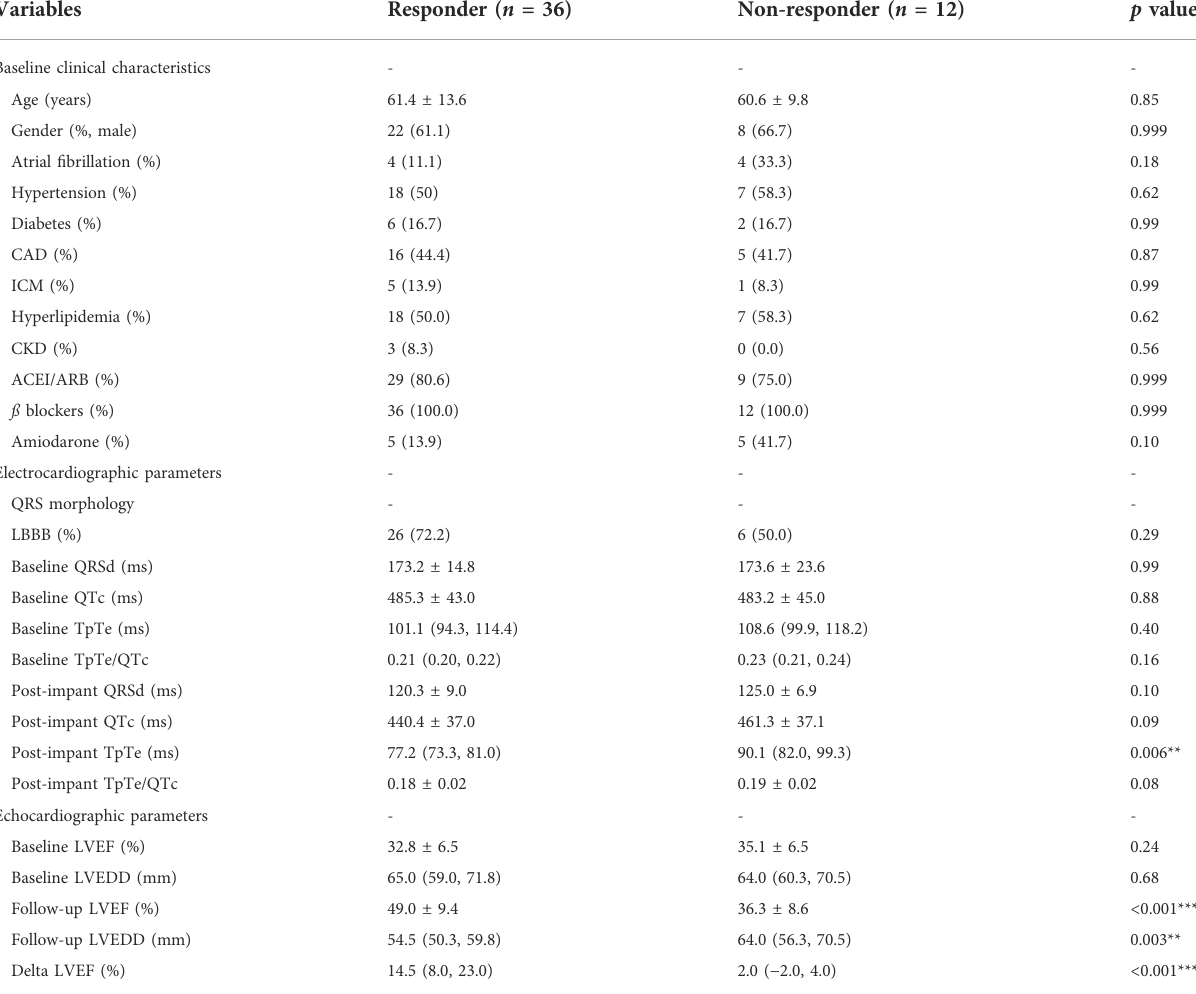
TABLE 4 Comparison of clinical, electro-cardiographic and echocardiographic data between responders and non-responders with QRS > 130